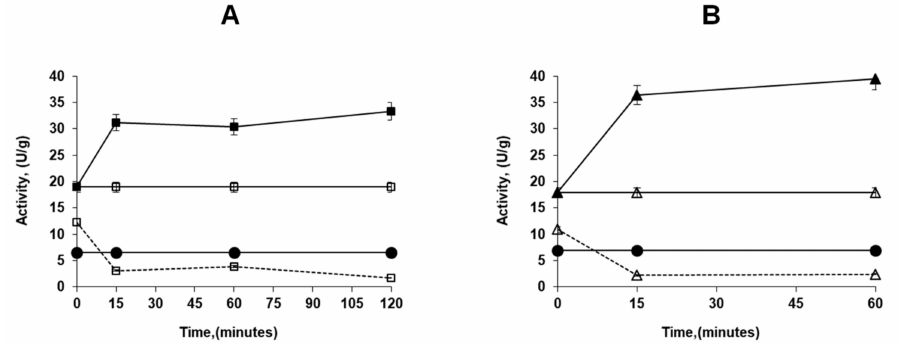
Figure 7. Courses of immobilization in the production of combibiocatalysts. Activity is given per gram of wet support used in the experiment. Experiments were carried out as described in Methods: ( A ) LU immobilized on reduced glyoxyl-octyl-PFL. Solid line, empty square: LU reference; solid line, solid square: suspension; dotted line, empty squares: supernatant; solid line, solid circle: reduced glyoxyl-octyl-PFL reference. ( B ) RML immobilized on reduced glyoxyl-octyl-PFL. Solid line, empty triangle: RML reference; solid line, solid triangle: suspension; dotted line, empty triangle: supernatant; solid line, solid circle: reduced glyoxyl-octyl-PFL.